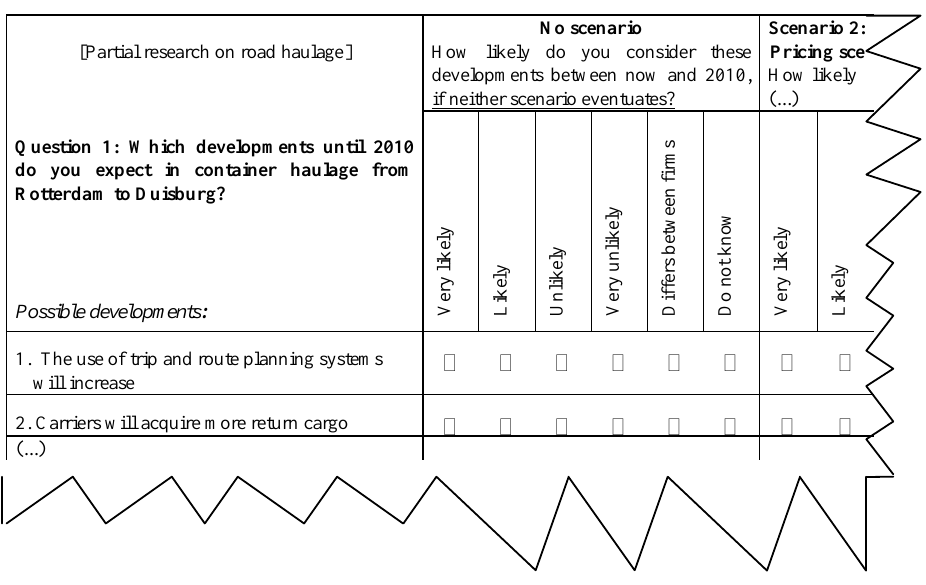
Figure 1. Illustration of the first part of the